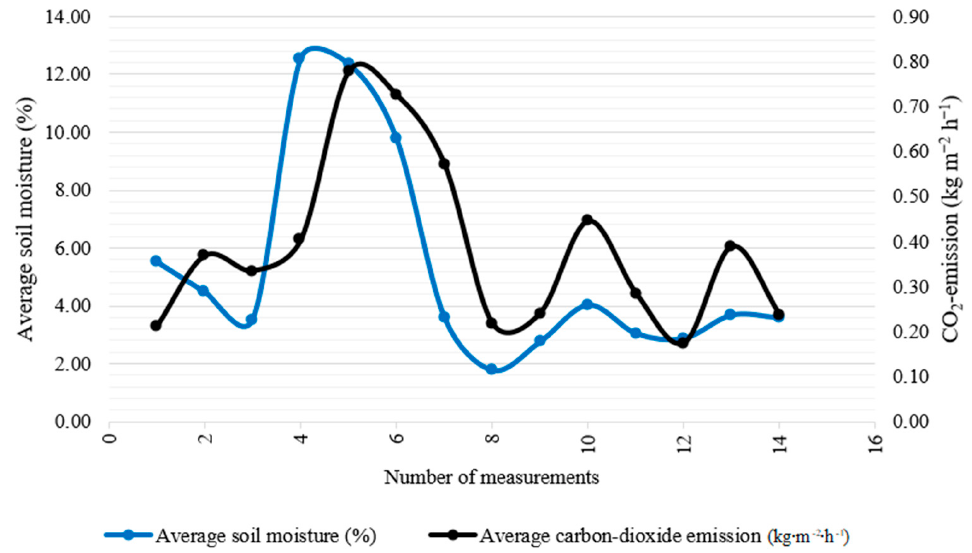
Figure 2. Soil moisture (%) and carbon-dioxide-emission (kg · m − 2 · h –1 ) results for the 2019 study period, independent of treatments (Karcag).